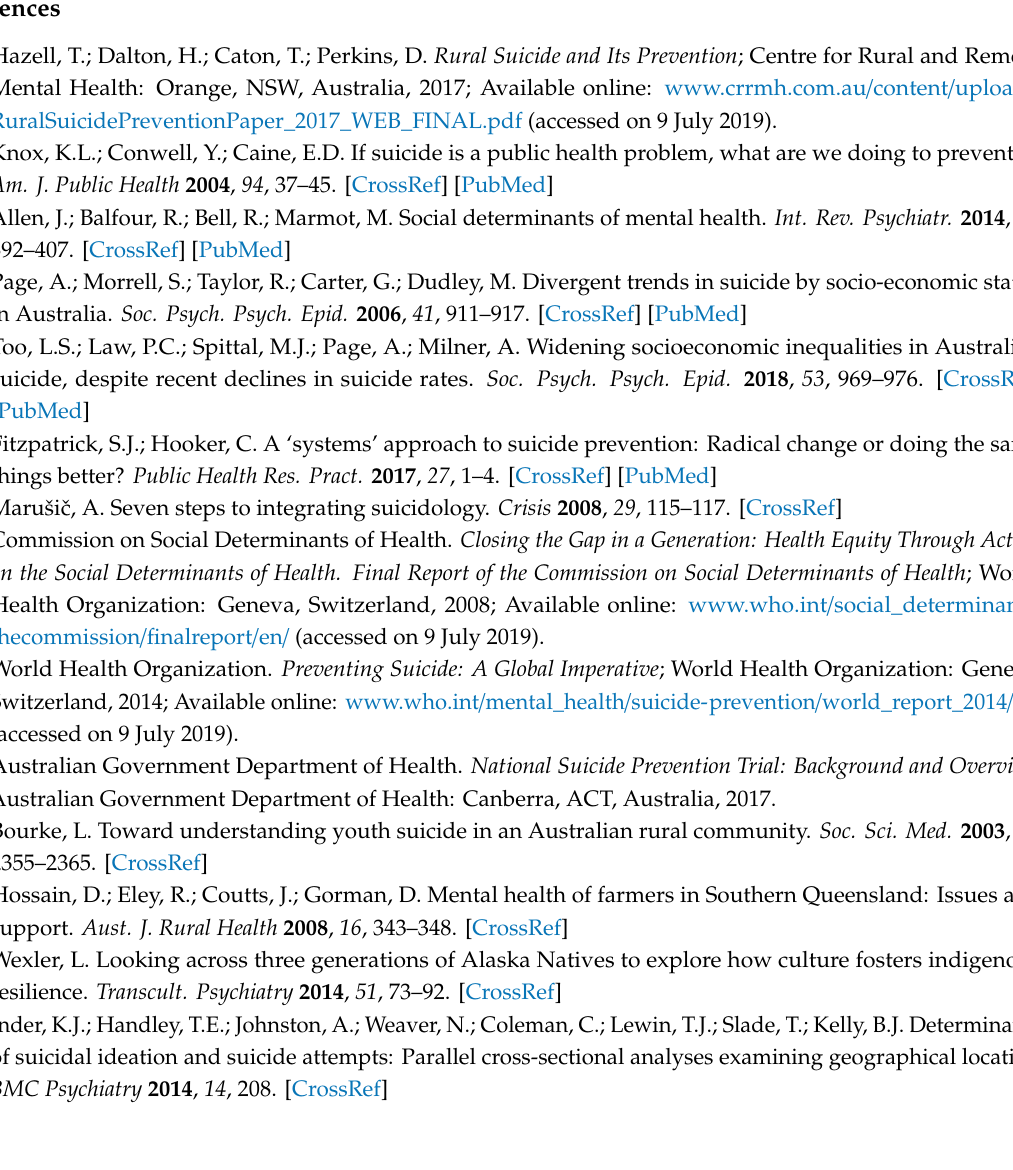
Table S1: Codebook for National Coronial Information System